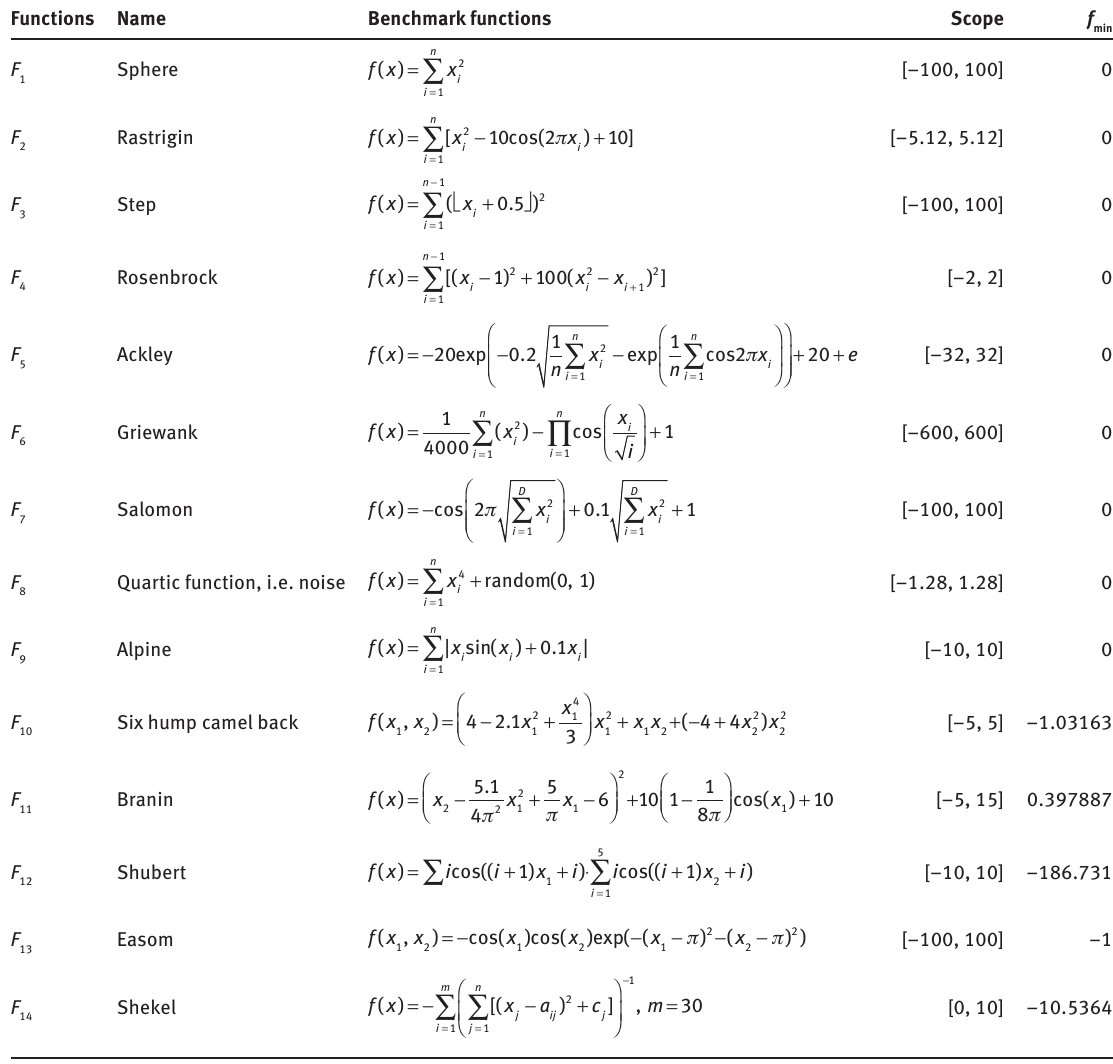
Table 3: Benchmark Test